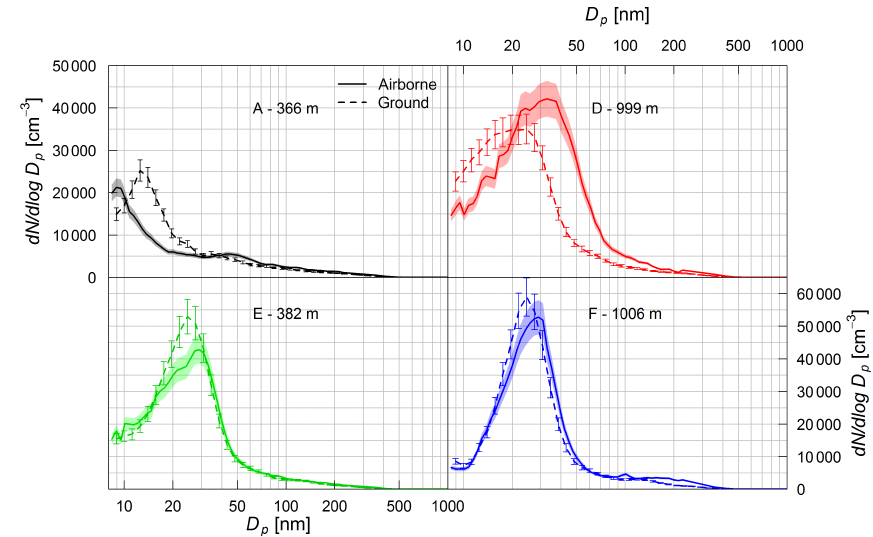
Figure 8. Airborne (solid lines) mean PNSD of flight 14b at standard conditions recorded during legs A (black), D (red), E (green), and F (blue) with the corresponding PNSD measured at Melpitz (dashed lines). Error bars and shaded areas represent the TROPOS standard uncertainty of TROPOS-built MPSS systems of